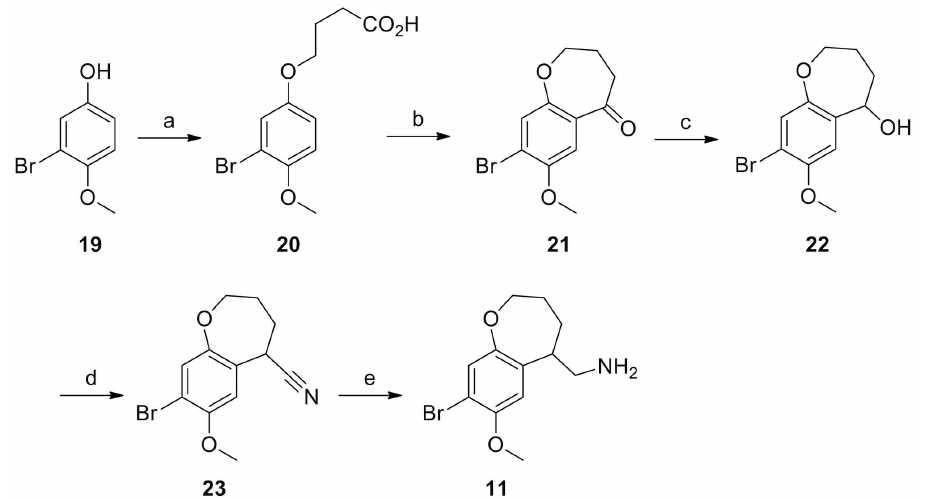
Figure 5. Synthesis of 11 . Reagents and Conditions: (a) Ethyl 3-bromobutyrate, Cs 2 CO 3 , MeCN, reflux, 2 hrs; (b) polyphosphoric acid, 90 u C for 1 h. (c) NaBH